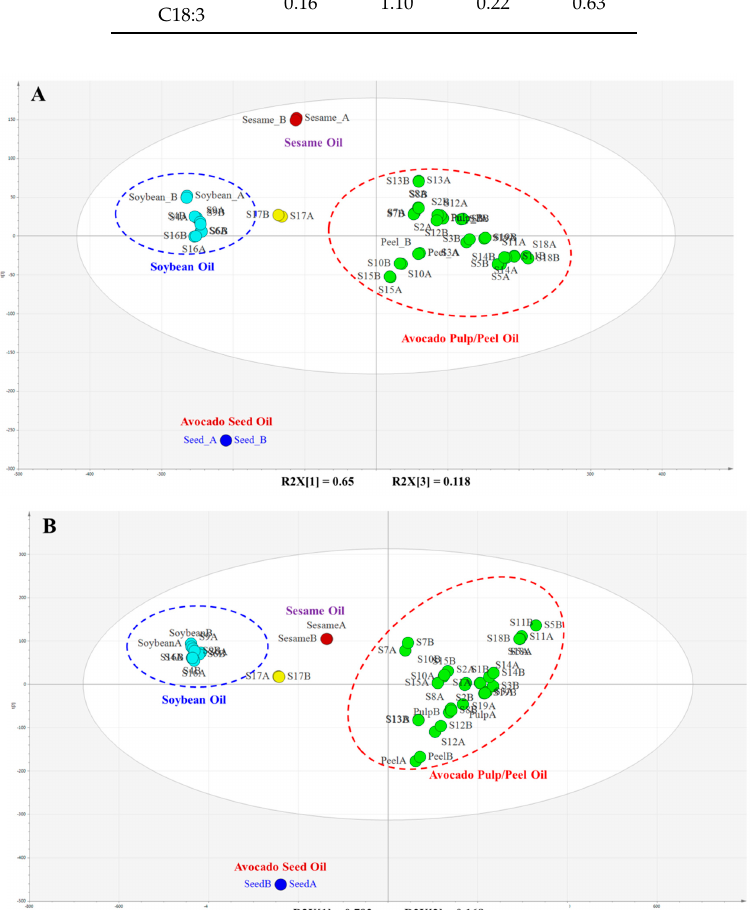
Figure 7. PCA score plots of authenticated and commercial avocado oils, sesame oil and soybean oil. ( A ) UHPLC/MS TG data and ( B ) GC/MS FA data. Each sample was prepared in duplicate.